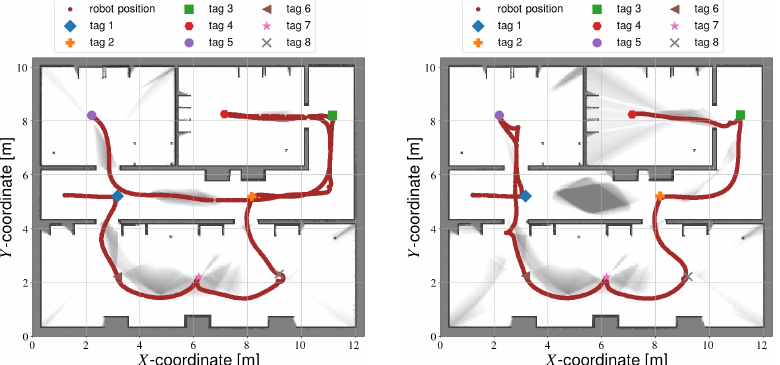
Figure 10. Calibration results from two different semi-autonomous